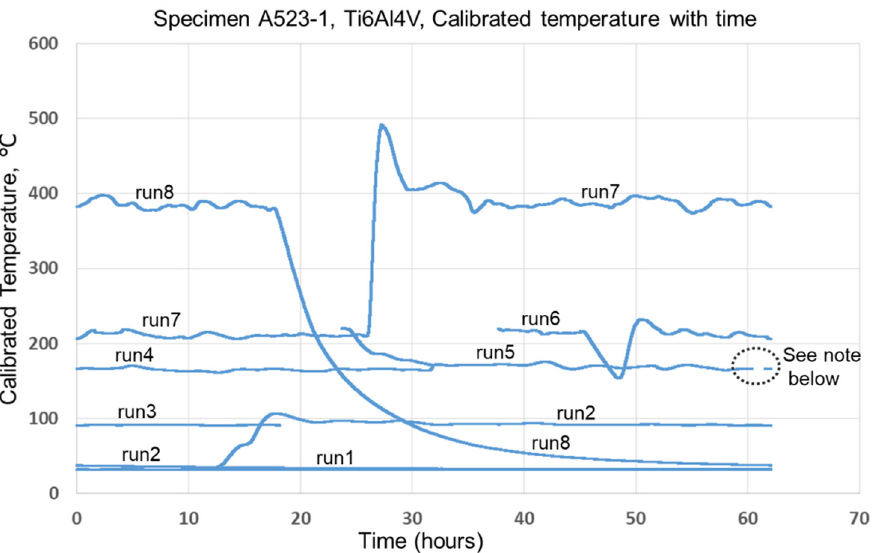
Figure 10. Calibrated temperature measurement using embedded FBG sensor on Ti6Al4V specimen A523-1. (Note: break in data due to fixing cable connections during run 5).